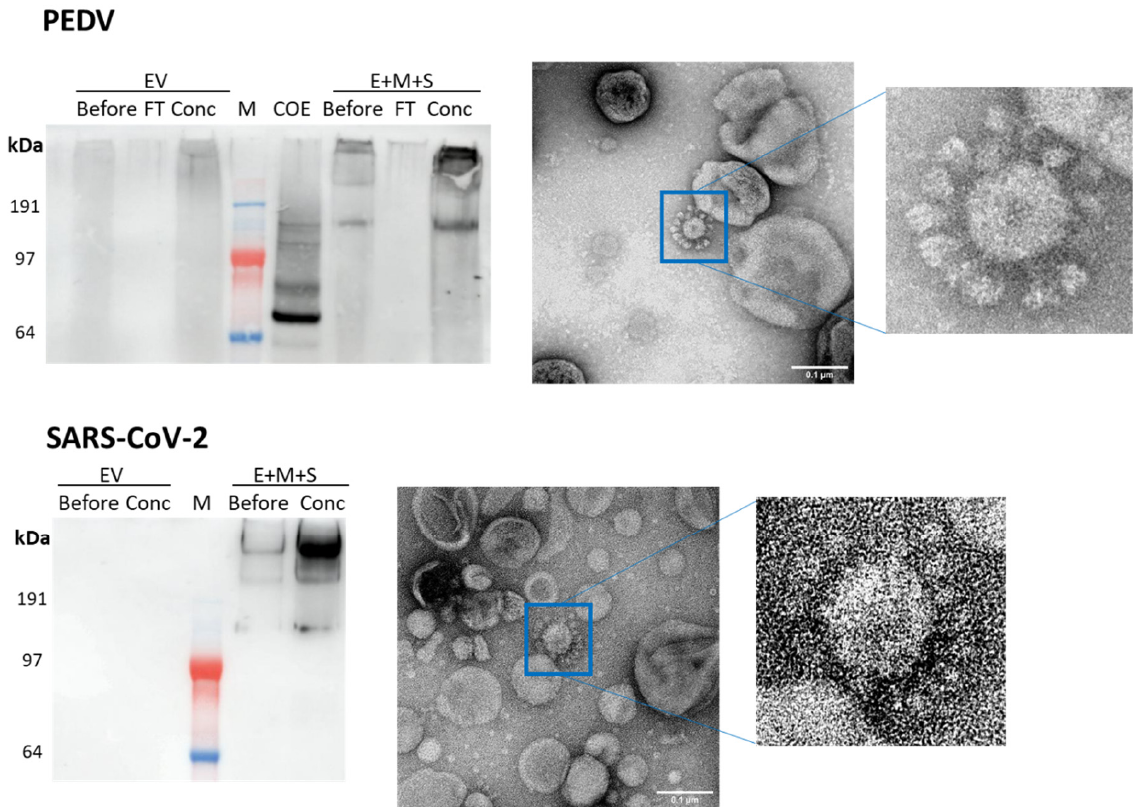
Figure 2. Transient co-expression of E, M and S coronavirus proteins leads to the formation of possible VLPs. Top: porcine epidemic diarrhoea virus, bottom: SARS-CoV-2. The E, M and S proteins are co-expressed in N. benthamiana and purified by sucrose cushion followed by a sucrose gradient then desalting column before concentration on a spin column concentrator. Left: anti-S Western blots on samples from co-expression of coronavirus proteins (E + M + S) or empty vector negative control (EV). Before: sample recovered from desalting column, FT: flow-through from spin-column concentrator, Conc: retentate from spin column concentrator, M: marker, COE: positive control. Right: transmission electron micrographs of Conc samples shown in Western blots. Samples stained with 2% ( w / v ) uranyl acetate, scale bars are 100 nm.